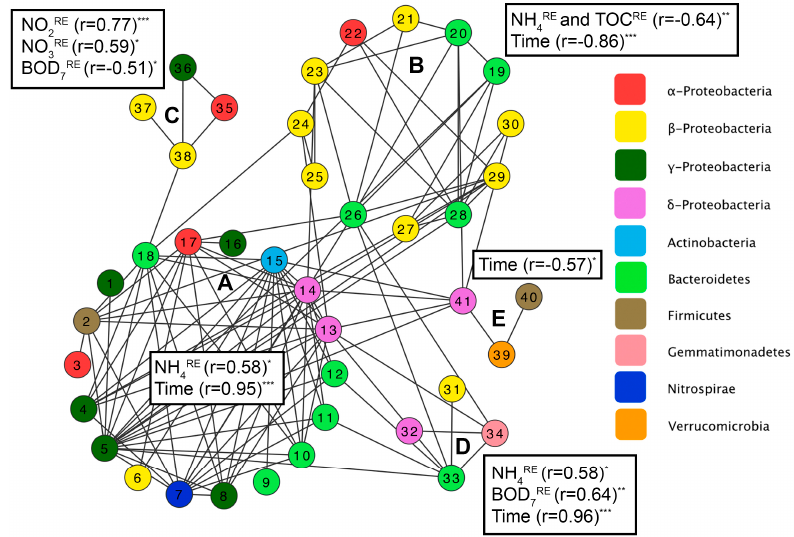
Figure 3. Molecular ecological network with module structure obtained by the simulated annealing approach. The phylogenetic affiliation of each node (OTU) is given on the level that was above the threshold (0.6) value. Phylogenetic affiliation of nodes: 1,8— Pseudomonas ; 2— Planococaceae ; 3— Brevundimonas